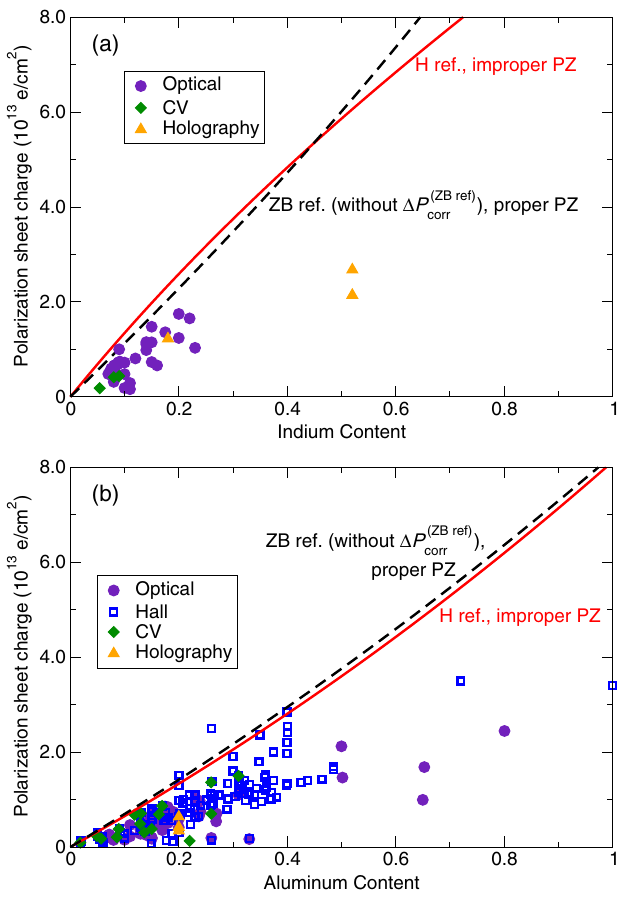
FIG. 2. Absolute values for polarization sheet charges at the (a) InGaN/GaN and (b) AlGaN/GaN interfaces as a function of alloy content predicted from the spontaneous polarization constants calculated using either the ZB reference structure [without a correction term, Eq. (14)] and the proper piezoelectric constants (black dashed curve), or the H reference structure and improper piezoelectric constants (red solid curve). Points are experimental values from the literature (see Sec. S3 of Ref. [15] for references and